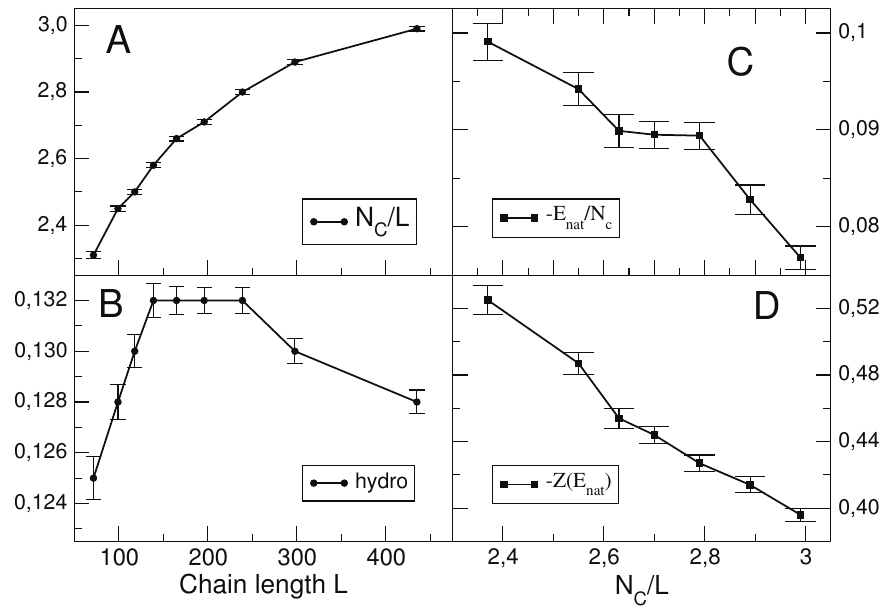
Figure 2. The number of contacts per residues, N the mean hydrophobicity reaches a maximum and then decreases for very long proteins ( B